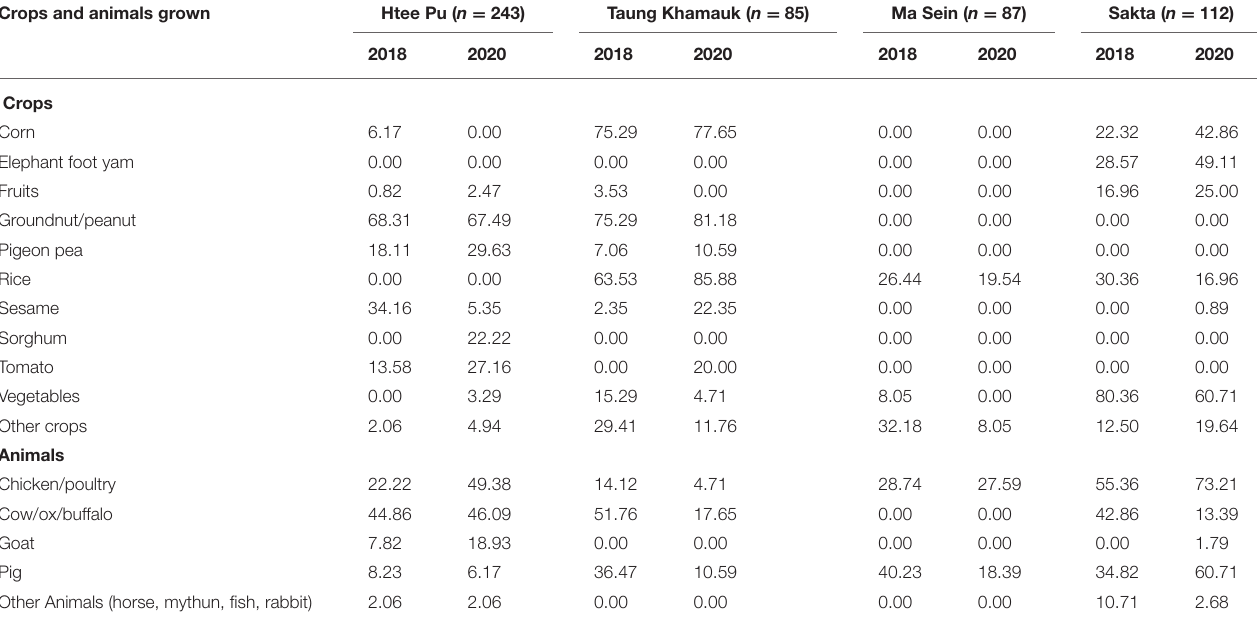
TABLE 9 | Percentage of households who cultivated crops and owned animals by village and by year, Myanmar. Crops and animals